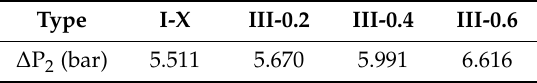
Table 4. Pressure drop in offset intersection.